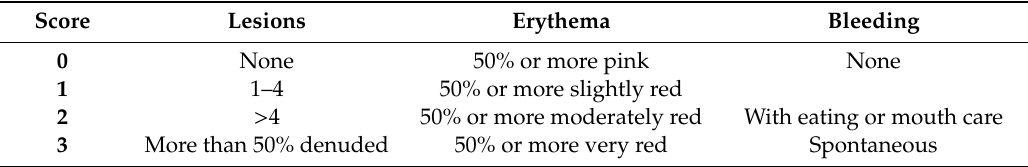
Table 3. Western Consortium for Cancer Nursing ResearchWCCNRstomatitis staging system.